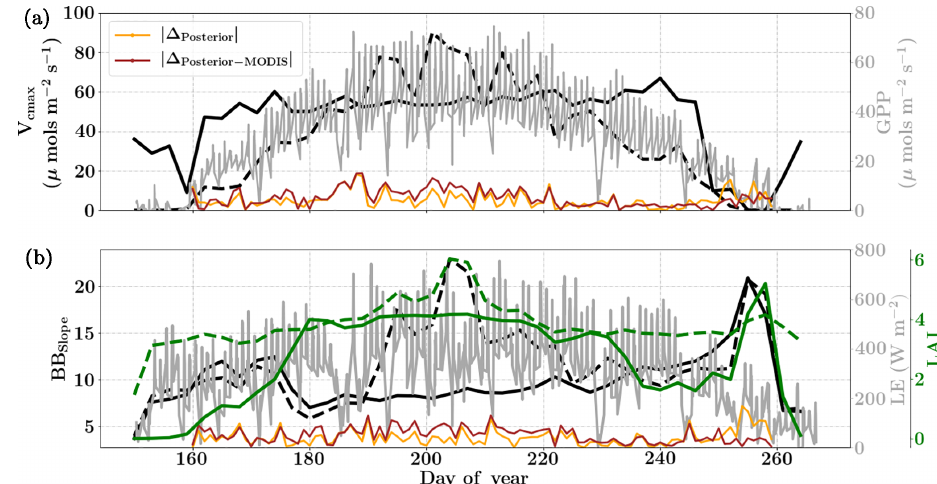
Figure 7. Figure showing the seasonal variability in retrieved parameter values of V cmax , BB slope and LAI for the Nebraska Mead-1 site using a 3-day moving window inversion approach for the year 2010. The actual points in the time series (grey lines) of the GPP and LE fluxes used as the target observations ( Y ) for the moving window inversion approach are shown in the background. The figure shows the comparison of the retrieved parameters using only GPP and LE fluxes (shown as dashed lines) as well as using a combination of fluxes and MODIS reflectance (shown as solid lines). The results show reasonable trends in the retrieved parameters along with their sensitivity to GPP and LE fluxes across the growing season.